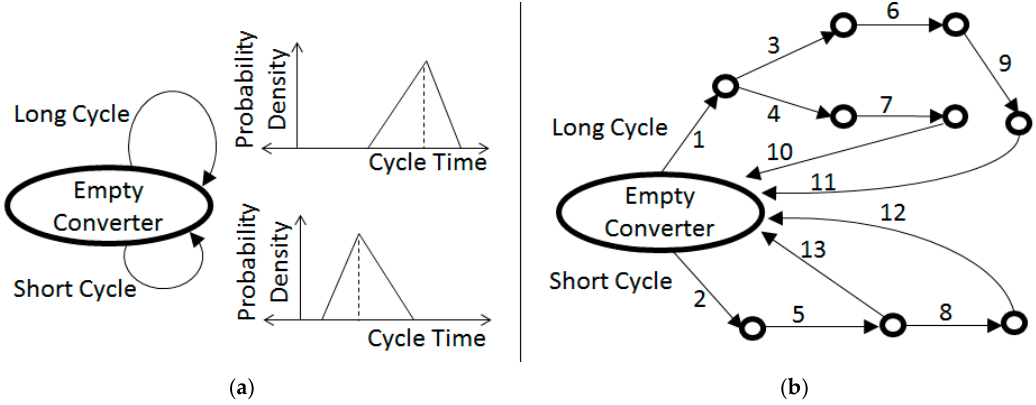
Figure 5. Examples of action graphs that represent Peirce-Smith converting cycles, which consider two types of cycles: long and short. ( a ) The low-detail representation shows the long and short cycles as single actions that are characterized by broad distributions of cycle times, whereas ( b ) a more detailed representation considers individual blow segments, from 1 to 13; each of the segments can be characterized by comparatively narrow time durations (which were omitted from the figure).